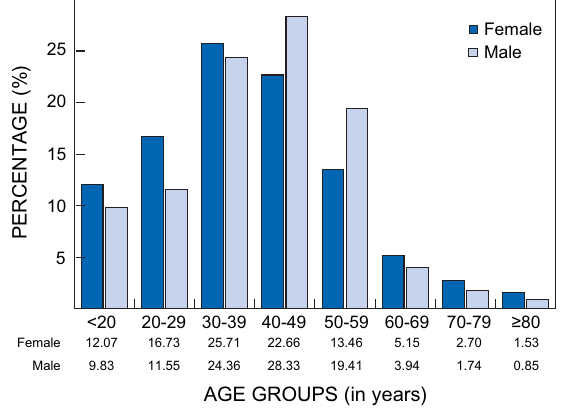
Figure 2: Number of prescriptions and number of patients according to age ( n = 20 326; n = 10 products patients